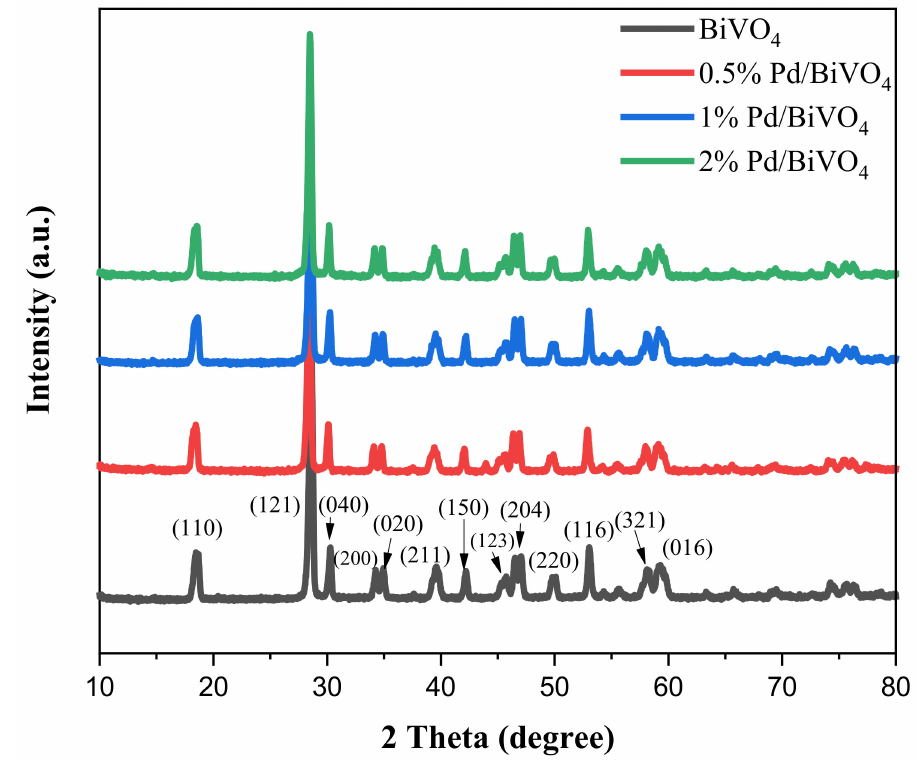
Figure 2. XRD patterns of obtained